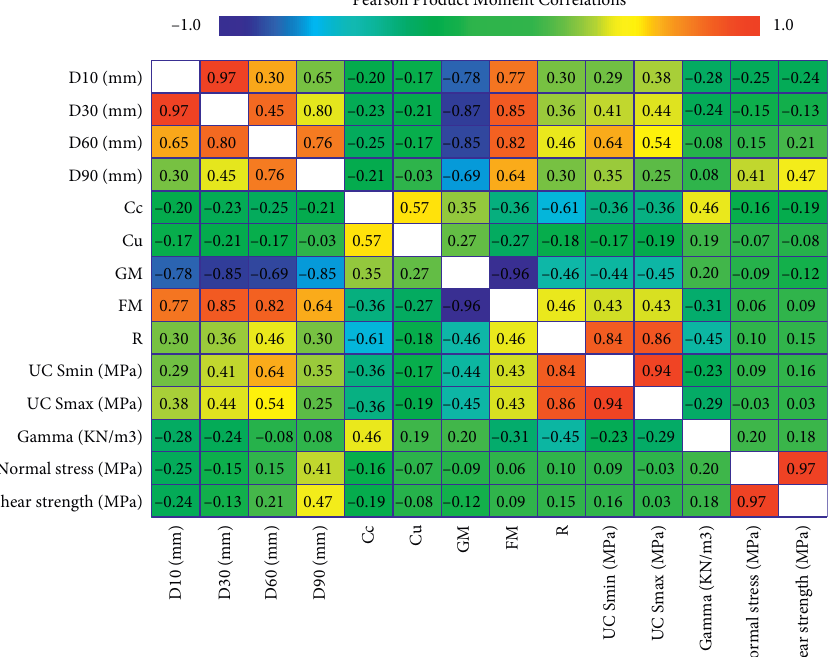
Figure 1: Correlation coefficient between